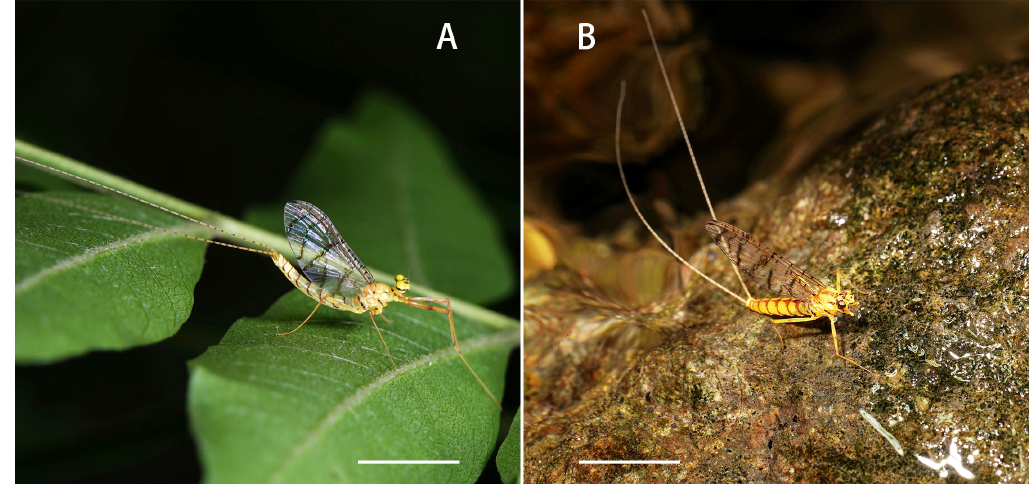
Figure 5. Adults of Regulaneuria cingulata : ( A ) Male imago habitus; ( B ) Female imago habitus. Scale bars: ( A , B ) = 5.0 mm.